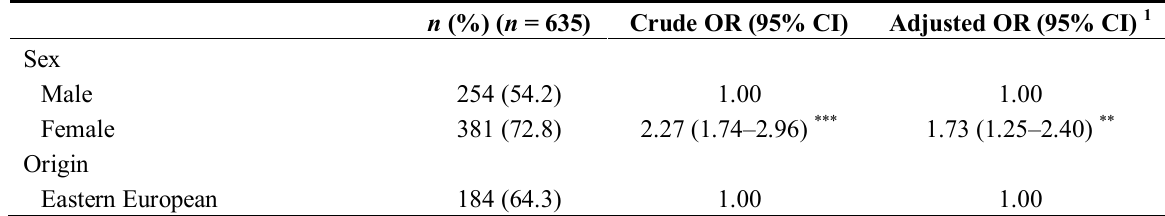
Table 3. Logistic regression results for factors associated with no condom use in the last sexual